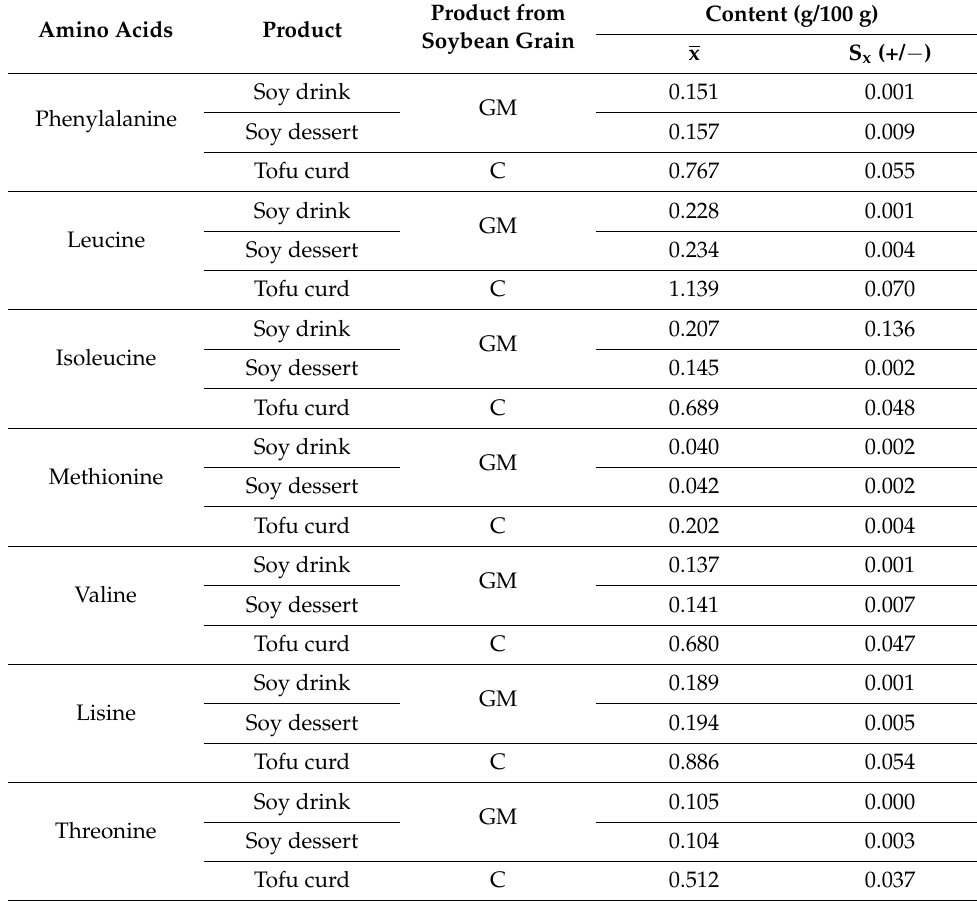
Table 4. Profile and content of exogenous amino acids of protein in soy drink and tofu made on the basis of GM soybean grains, and in tofu curd made on the basis of conventional soybean grains. Amino Acids